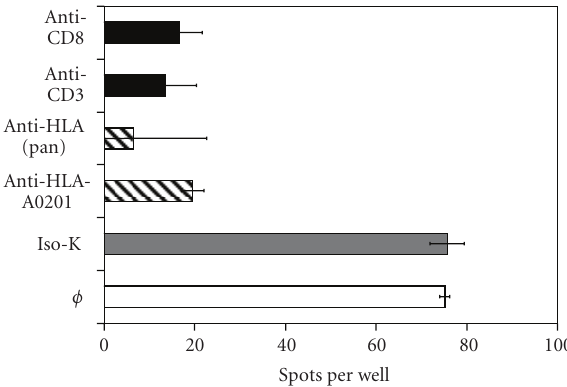
Figure 4: Antibody-blocking ELISpot analysis. FSP11 recognition of FSP11-specific T cells could be blocked by antibodies towards HLA(pan), HLA-A0201, CD3, and CD8 but not by IgG2 control antibody. The reactivity without the addition of antibodies is given as positive control. T2 cells loaded with FSP11 were used as targets. Either T2 cells or T cells were preincubated with antibodies towards HLA(pan) and HLA-A0201 (T2) or CD3 and CD8 (T cells) for one hour prior to setup of the ELISpot.